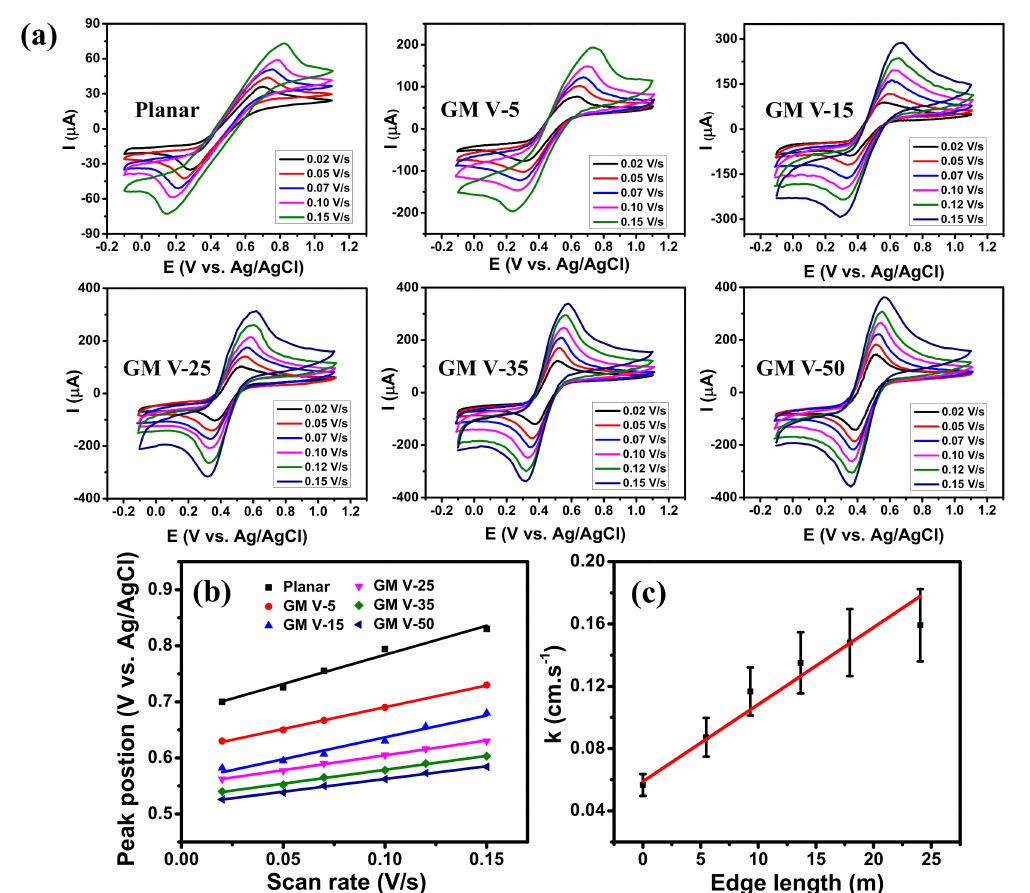
Figure 4. ( a ) CV diagrams of the graphene samples obtained at different scan rates in 1 mM ferrocene and 0.1 M Bu 4 NPF 6 in acetonitrile electrolyte. ( b ) Anodic peak position vs. scan rate and ( c ) Electron transfer rate constant versus edge length of the graphene